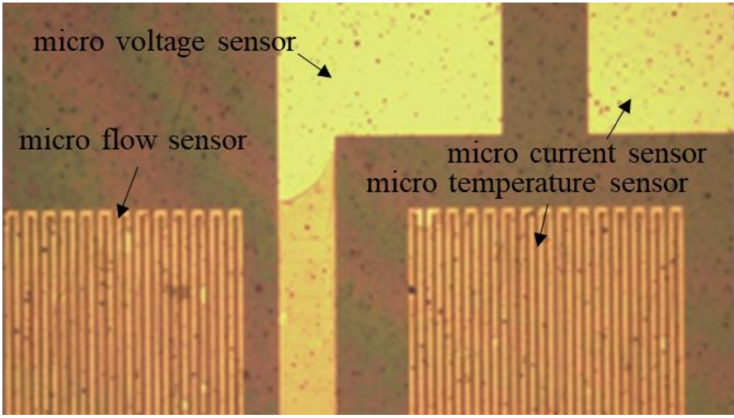
Figure 3. Partial optical microscope view of flexible, multifunctional micro-sensor.